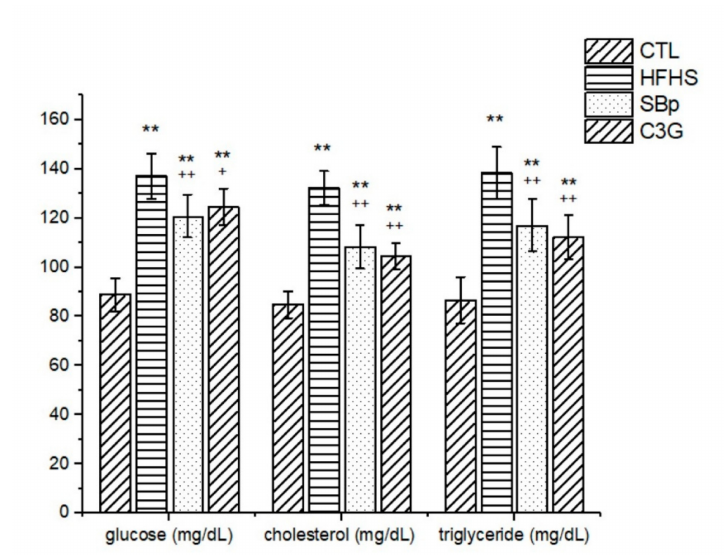
Figure 2. Levels of glucose, cholesterol and triglycerides in plasma of mice fed with HFHS diets supplemented with or without C3G. The dietary regimen was the same as described in the legend of Figure 1. Fasting plasma glucose, cholesterol and triglycerides were measured biochemically using assay kits. Values are expressed as mean ± SD mg / dL ( n = 8 / group). **: p < 0.01 versus the control (CTL) group; + , ++ : p < 0.05 or 0.01 versus the HFHS group.